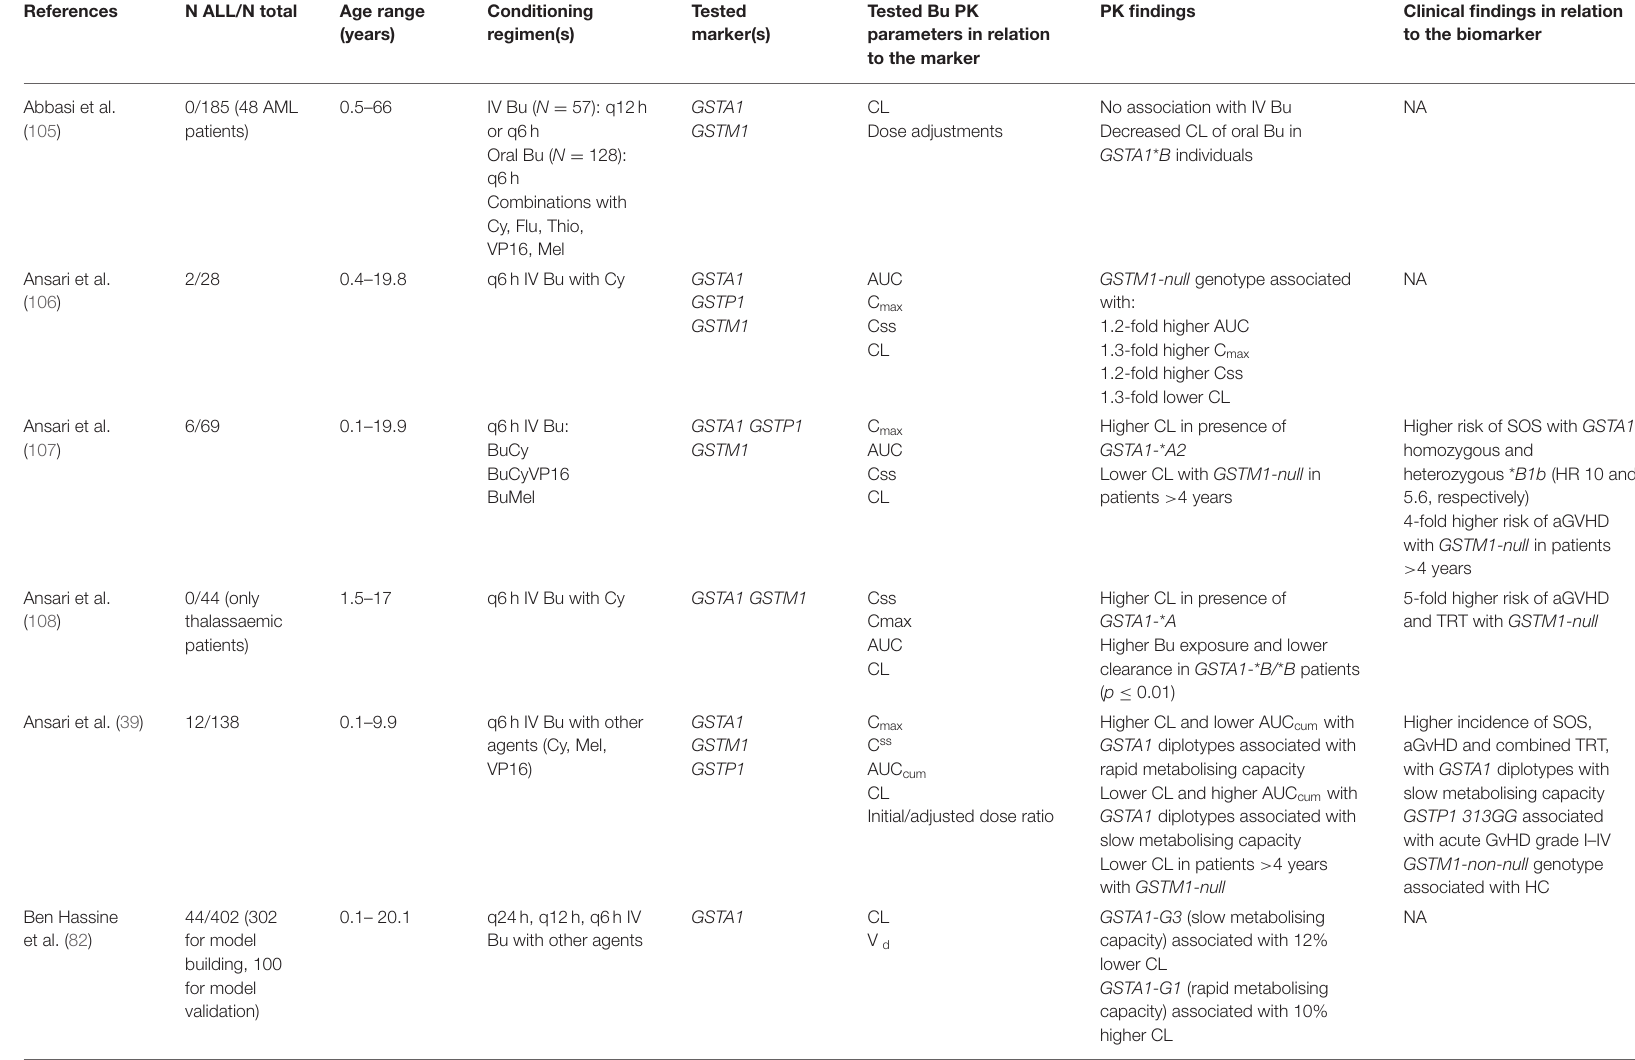
TABLE 3 | Summary of studies assessing busulfan pharmacogenetics and